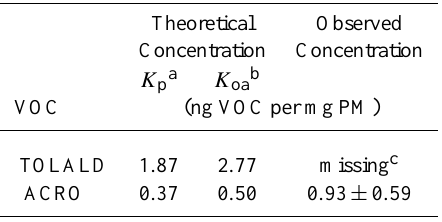
Table 6. Theoretical and observed values for partitioning of TO- LALD and ACRO to PM. Theoretical Observed Concentration Concentration K pa K oab VOC (ng VOC per mg PM) TOLALD 1 . 87 2 . 77 missing c ACRO 0 . 37 0 . 50 0 . 93 ± 0 .